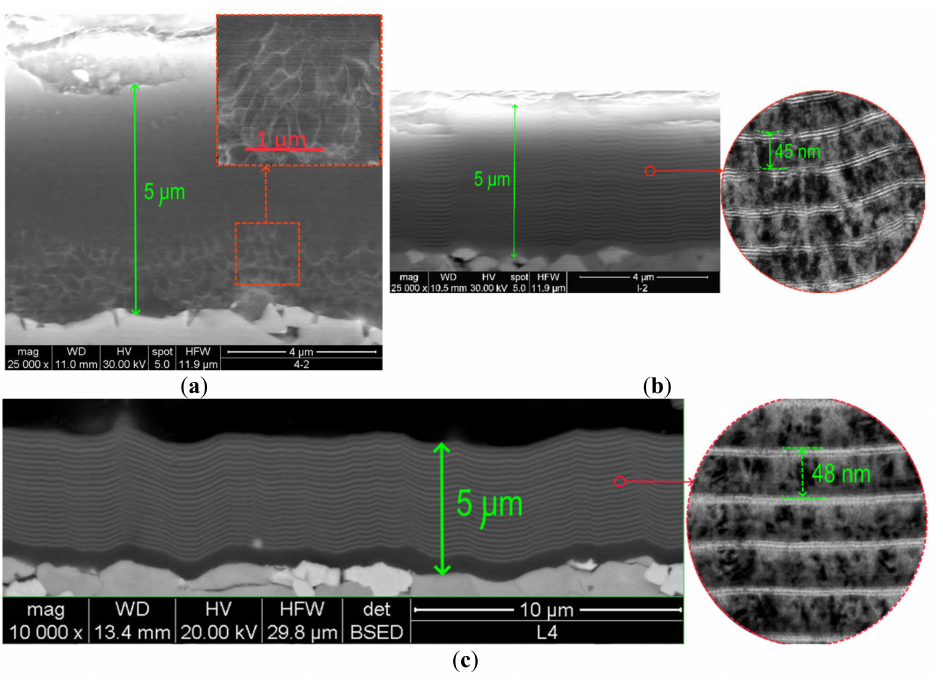
Figure 1. Structure of the coatings: ( a ) ZrN, ( b ) Ti-TiN-(Ti,Cr,Al)N, and ( a ) Zr-ZrN-(Zr,Mo,Al)N. SEM, except for the high-resolution (HR) images of the coating structures on ( b , c ) obtained using TEM. Due to the difference between the SEM and TEM techniques and the different resolutions of the corresponding images, the SEM image exhibits only the alternation of the modulation periods, while the TEM image demonstrates the features of the nanolayered structure of the